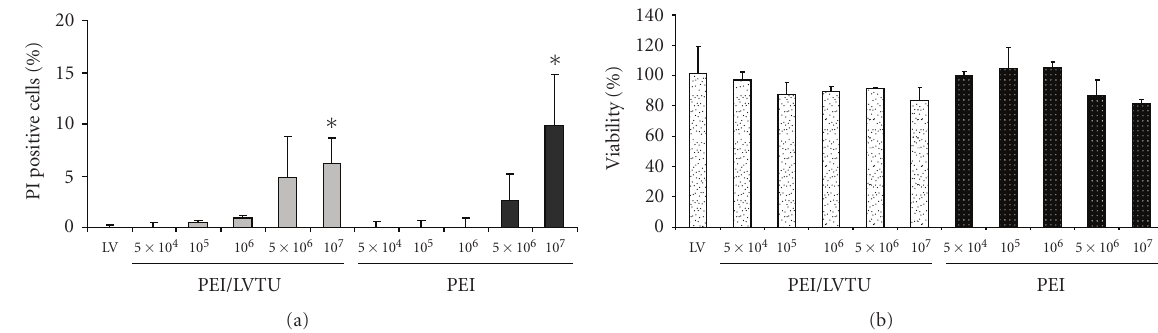
Figure 6: Cytotoxicity of PEI/LV vectors . Polarized 16HBE41o- cells were incubated with LV (50 MOI) either alone or formulated at di ff erent PEI molecules/TU ratios with 50 MOI LV for 24 hours and then analyzed for propidium iodide staining (a) or MTT assay (b). The same amounts of PEI used in the formation of PEI/LV vectors were tested for their cytotoxicity. Percentage of propidium iodide (PI)-positive cells incubated with medium only was 4.68 ± 1.8 and subtracted from the other values. In the viability assay, untreated cells were incubated with medium only and considered as 100%. Data are expressed as means ± SD of two-three experiments. a: ∗ P < . 05 for 10 7 PEI/LV TU and free PEI versus all the other conditions except 5 × 10 6